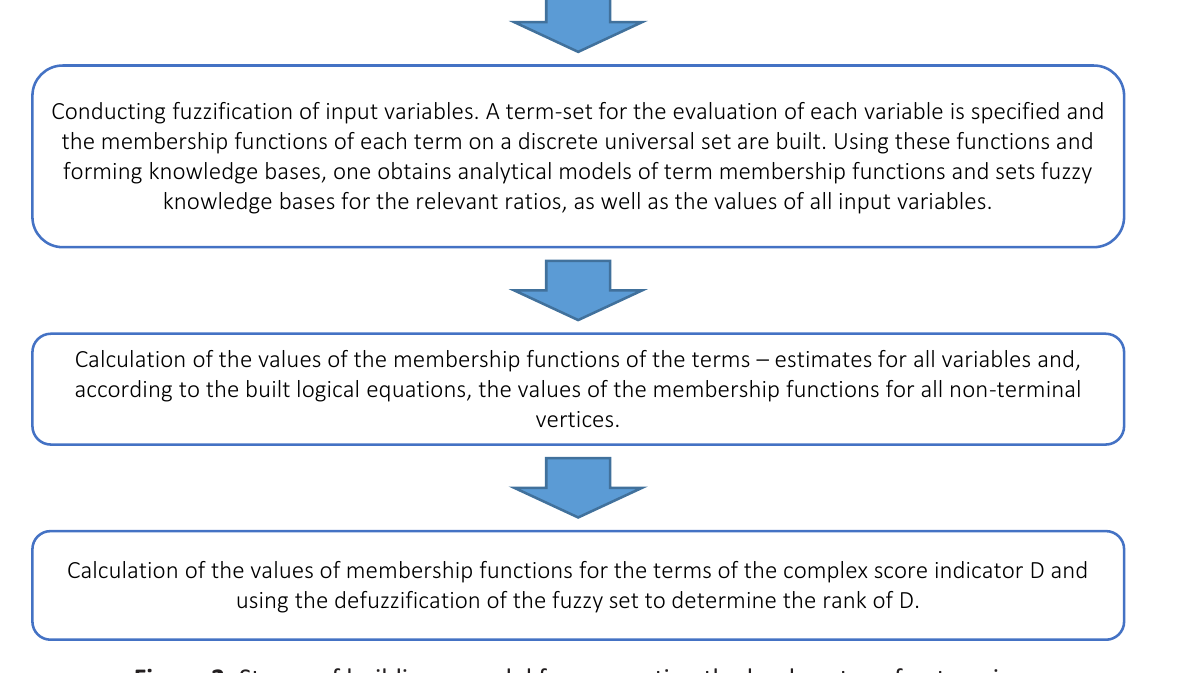
Building a logical conclusion tree will determine the sequence of further